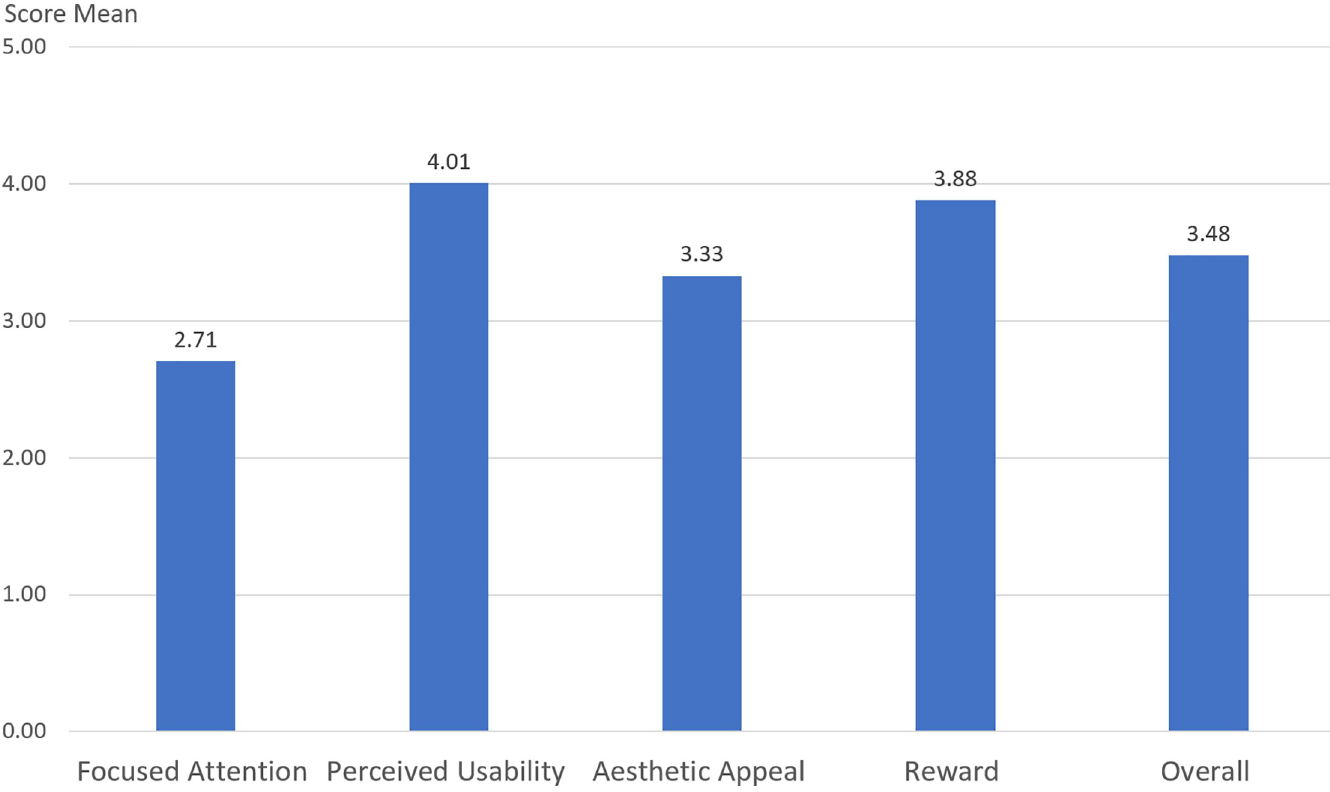
Fig 3. User engagement scale based on O’Brien et al.